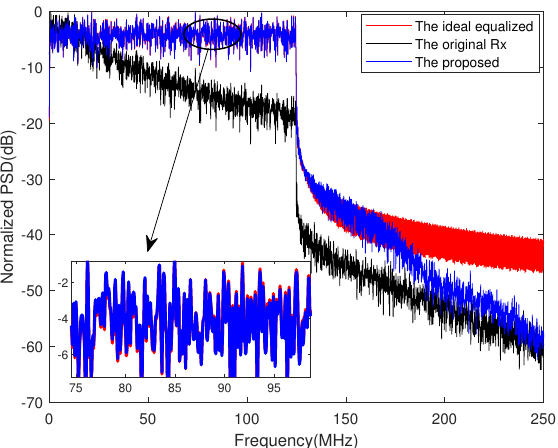
Figure 7. PSD performance comparison of the proposed scheme with the ideal case.